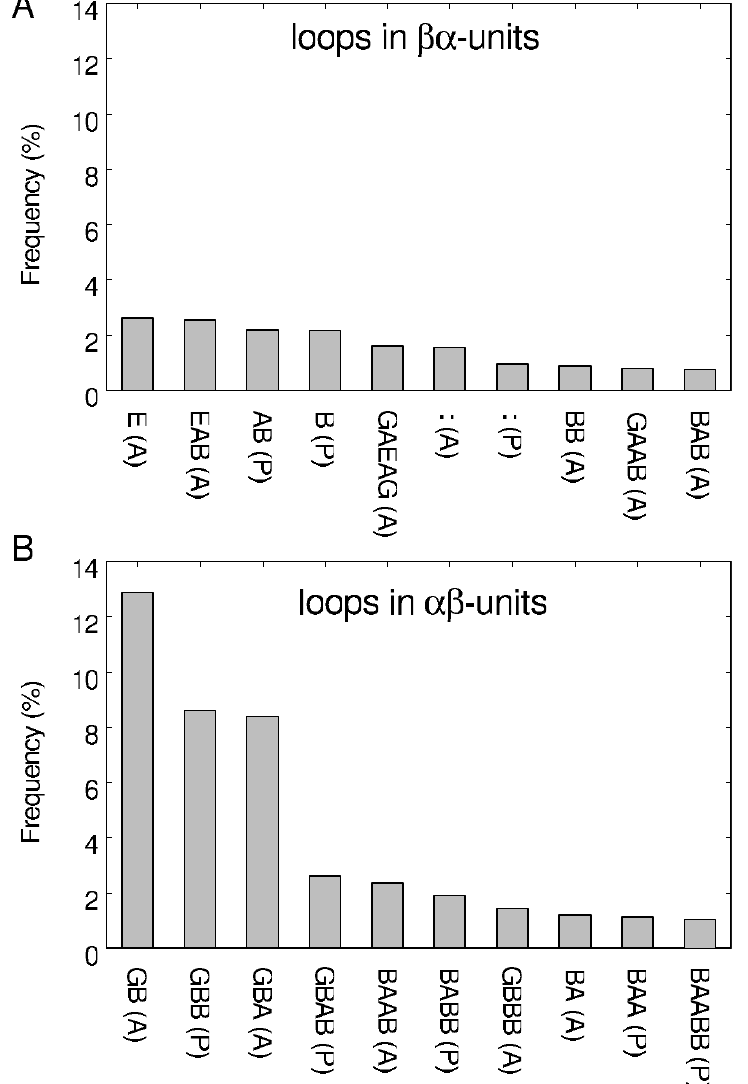
Fig 2. Observed frequency of loop types in βα (A) and αβ (B) units, as classified based on the ABEGO representation and packing geometry. The horizontal axis is sorted by frequency of occurrence and the 10 most frequently observed loops are shown. The packing geometry, i.e., parallel or anti-parallel, was defined based on the orientation of the C α -C β vector of the strand residue closest to the helix relative to the vector from the first to the second secondary structure element [4]. If the two vectors were parallel, the orientation was denoted as “(P)”, and if anti-parallel, the orientation was denoted as “(A)”. The character “:” denotes the zero-length